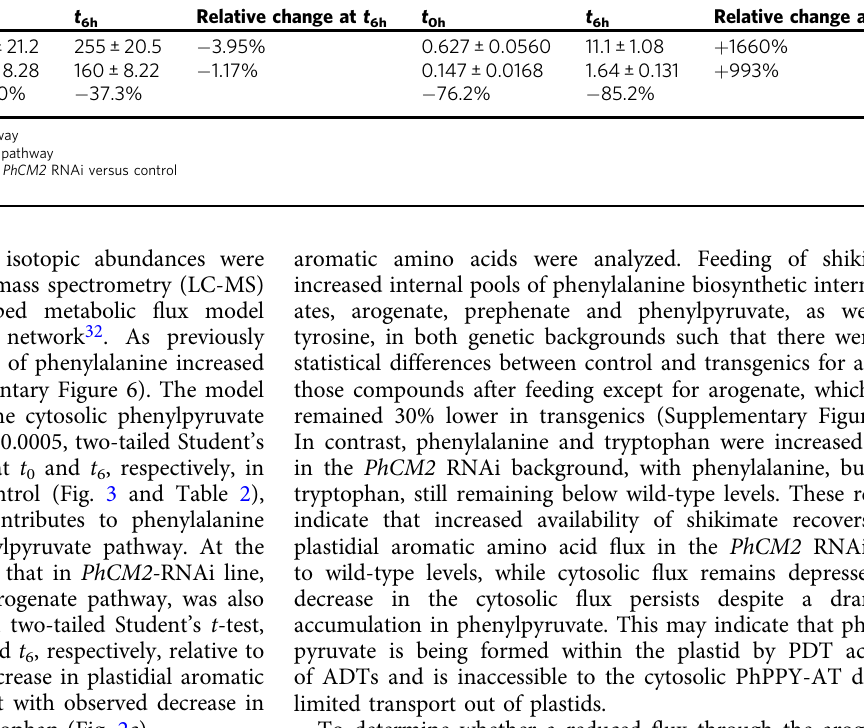
Fig. 3 Metabolic modeling of phenylalanine biosynthetic pathways in control and PhCM2 RNAi petunia fl owers. Flux models representing the phenylalanine biosynthetic network in 2-day-old control and PhCM2 RNAi petunia fl owers. Metabolic modeling was performed using pool sizes and isotopic abundances of phenylalanine and tyrosine, and measurements of phenylalanine-derived volatile emission (consumption fl ux, v c , blue lines) from petunia petals supplied with 10 mM 15 N-tyrosine for up to 6 h starting at 18:00 h ( n = 3 biological replicates). v 1 fl ux through the plastidial arogenate pathway (green lines), v 2 fl ux through the cytosolic phenylpyruvate (pink lines, also is enlarged in inserts). The v 2 / v 1 ratio is shown by black lines. Solid lines are estimated values and dotted lines are standard deviation for each fl ux value Table 2 Changes in fl ux in fl owers from control and PhCM2-RNAi petunia lines at t 0h and t 6h Plastidial synthesis rate v 1